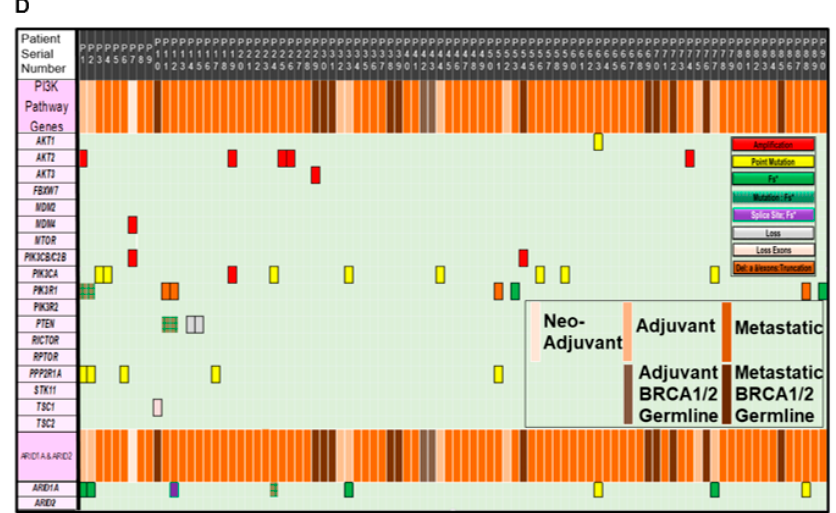
Figure 2. Alterations of ARID1A and genes of the PI3K-pathway genes in Patients with Ovarian Cancers from Avera Cancer Institute. Alterations of ARID1A and genes of the PI3K-pathway as well as a heatmap of co-distribution of these genes in tumors from patients with ovarian cancers at Avera Cancer Institute are presented. De-identified patients were represented with serial numbers. ( A ) presents the spectrum of alteration (number and types of alterations) in the ARID1A gene in tumors from ovarian cancer patients. The data were obtained from FoundationOne reports from 90 ovarian cancer samples. Patients’ tumors were sorted according to the clinical stages, neo-adjuvant, adjuvant, adjuvant BRCA1 / 2 germline, metastatic, and metastatic BRCA1 / 2 germline as presented with the color codes as an inset. Di ff erent types of alterations recorded in the ARID1A gene are also presented in the figure as an inset. ( B ) presents the mutational spectrum of ARID1A in ovarian cancer cohort of the Avera Cancer Institute. The data were obtained from FoundationOne reports from 90 ovarian cancer samples. Details of the mutations in individual samples are plotted on the linear representation of the ARID1A in the cartoon. Major domains of ARID1A are presented in the cartoon with the approximation of the amino acid numbers. The details of the alteration(s) are color-coded in the figure. Di ff erent types of alterations recorded in the ARID1A gene are also presented in the figure as an inset. ( C ) presents the number of alterations recorded in tumors in the genes of the PI3K pathway from patients with ovarian cancers in the Avera Cancer Institute. The data were obtained from FoundationOne reports from 90 ovarian cancer samples. ( D ) presents the co-distribution of alterations (FoundationOne) of the ARID1A gene with the genes of the PI3K pathway as recorded in the 90 ovarian cancer patients at the Avera Cancer Institute. The sorted data has been used to generate a heatmap to present the co-alteration pattern of the types of alterations of ARID1A genes and alterations of the PI3K pathway genes. The vertical column represents a patient, while the horizontal rows represent di ff erent genes of the PI3K pathway, ARDI1A gene, and ARID2 gene. The clinical stages, neo-adjuvant, adjuvant, adjuvant BRCA1 / 2 germline, metastatic, and metastatic BRCA1 / 2 germline, are presented with the color codes as an inset. Di ff erent types of alterations recorded in the ARID1A gene are also presented in the figure as an inset.